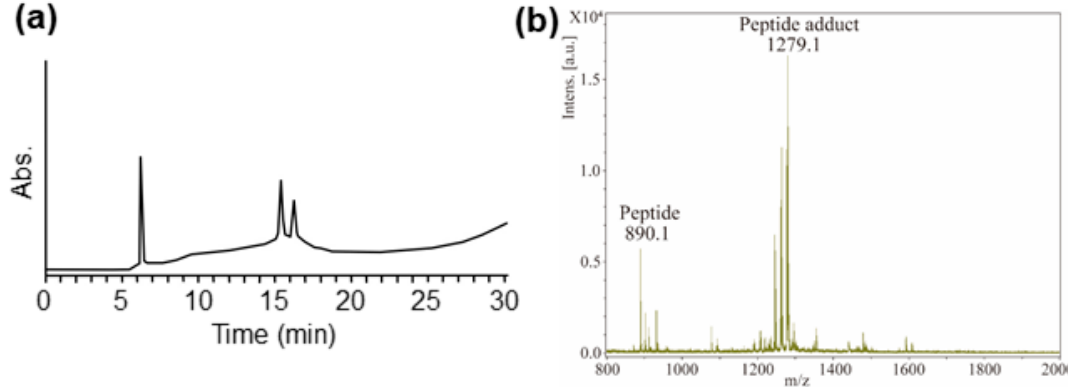
Figure 3. ( a ) HPLC chromatographs of peptide adducts after reaction of a mixture of FITC- isopropanol (IPA) with Lys-peptide-npp resin. ( b ) Mass spectrum at the retention time of 15–16 min in HPLC from Figure